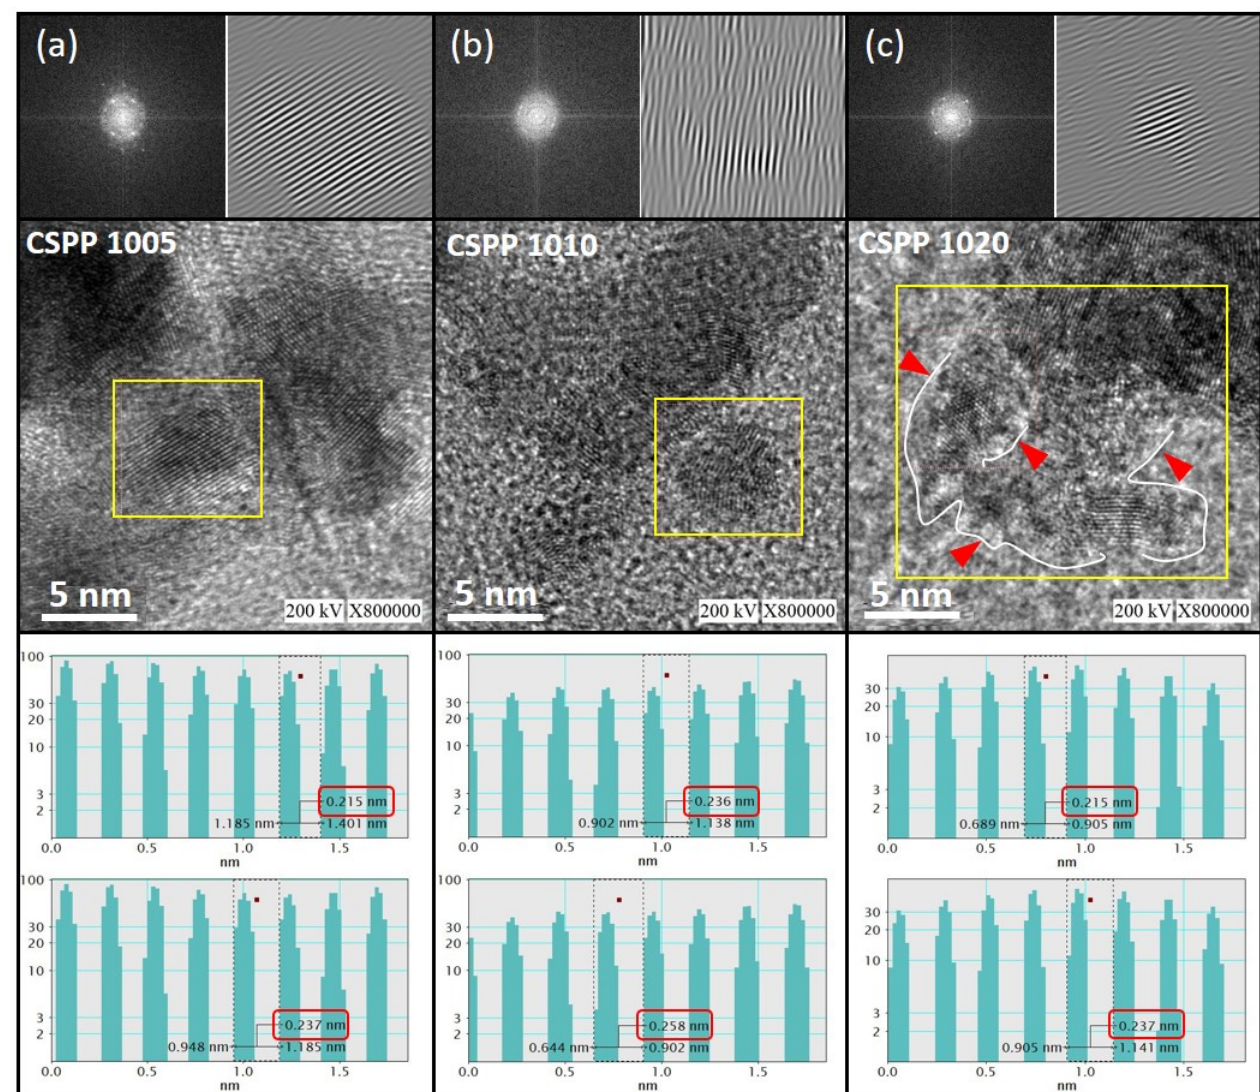
Figure 1. HRTEM images of CSPP NCs ( a ) CSPP 1005, ( b ) CSPP 1010, and ( c ) CSPP 1020. The d-spacing values of experimental NCs are calculated by using Inverse Fourier Transform (IFT) images (upper right corners) and their corresponding line histograms (insets). Fourier transformation (FFT) patterns of the selected area in the HRTEM images are shown in the upper left corners.